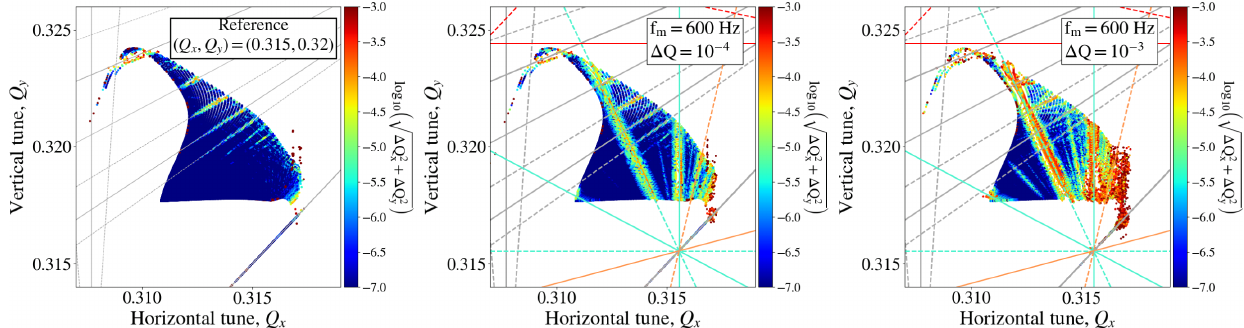
FIG. 7. The frequency maps at the optimized working point ð Q x ; Q y Þ ¼ ð 0 . 315 ; 0 . 32 Þ , without considering synchrotron oscillations, with the reference conditions (left) and with a tune modulation at 600 Hz with Δ Q ¼ 10 − 4 (middle), and Δ Q ¼ 10 − 3 (right). The gray lines represent the nominal resonances, while the cyan lines the m ¼ 1 and N ¼ 3